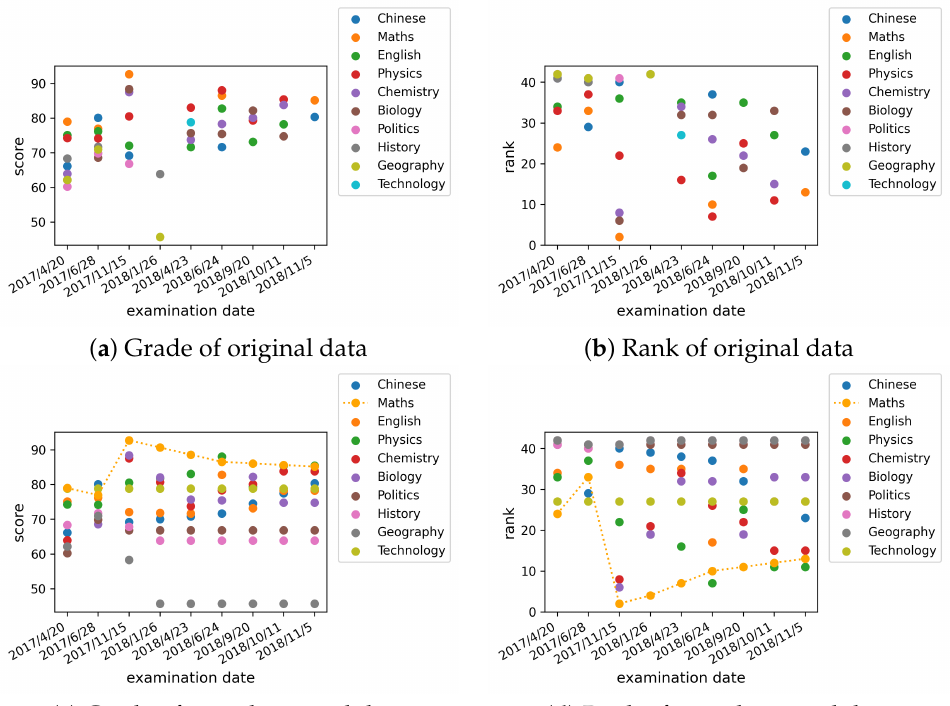
Figure 8. The original data and the complementary